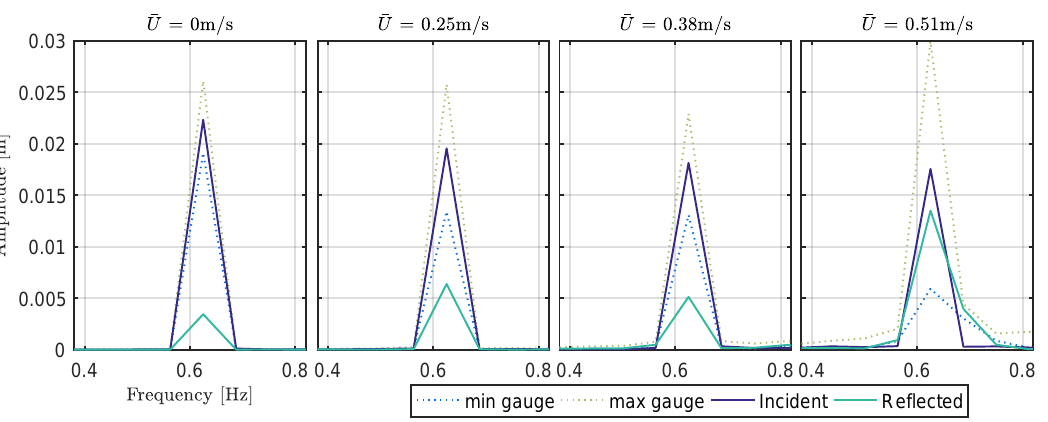
Figure 9. Incident and reflected amplitude spectra for the regular wave cases corresponding to Sea States 1–4 in Table